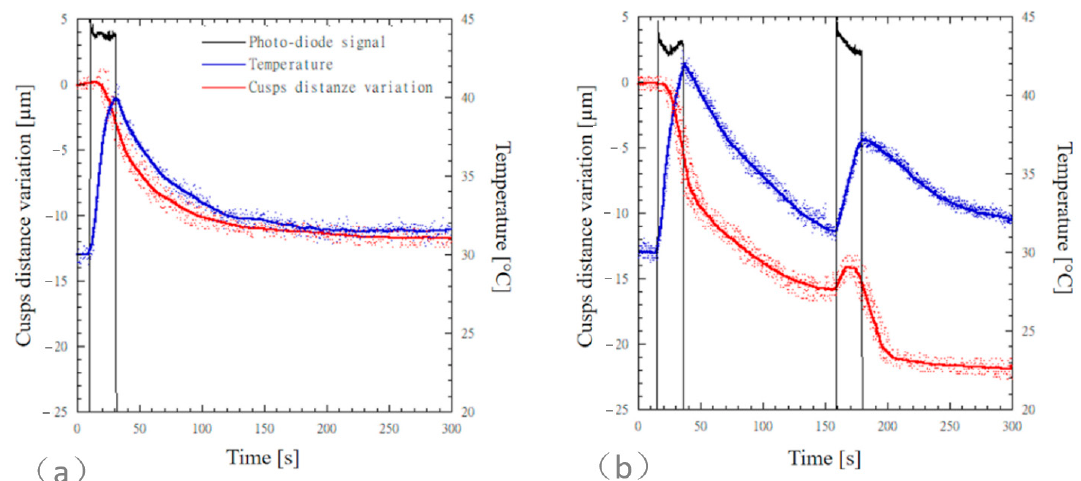
Figure 4. Simultaneous time measurements of cuspal distance variation, temperature, and photodiode Figure 4 signal for MOD cavities restored with SDR flow + . The photodiode signal is reported on an arbitrary scale and it was used to detect the light curing and the dark reaction phases. MOD cavities restored according to ( a ) the bulk-fill technique and ( b ) the incremental